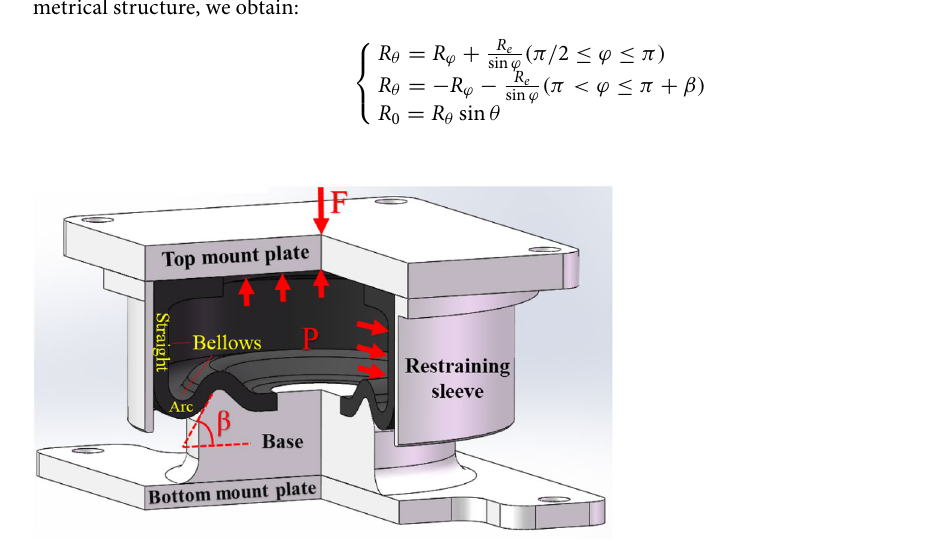
Figure 1. Schematic diagram of an air spring